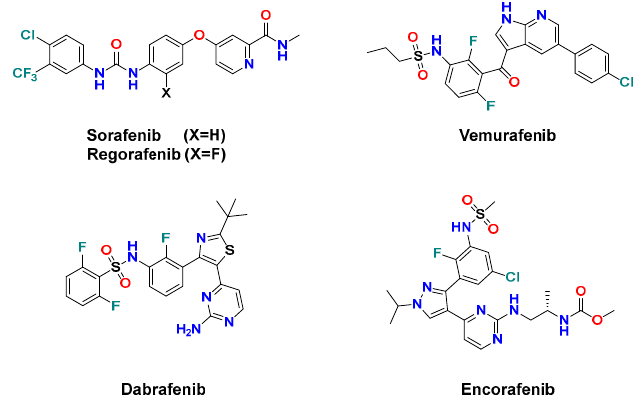
Figure 1. FDA-approved anticancer B-RAF/C-RAF inhibitors.